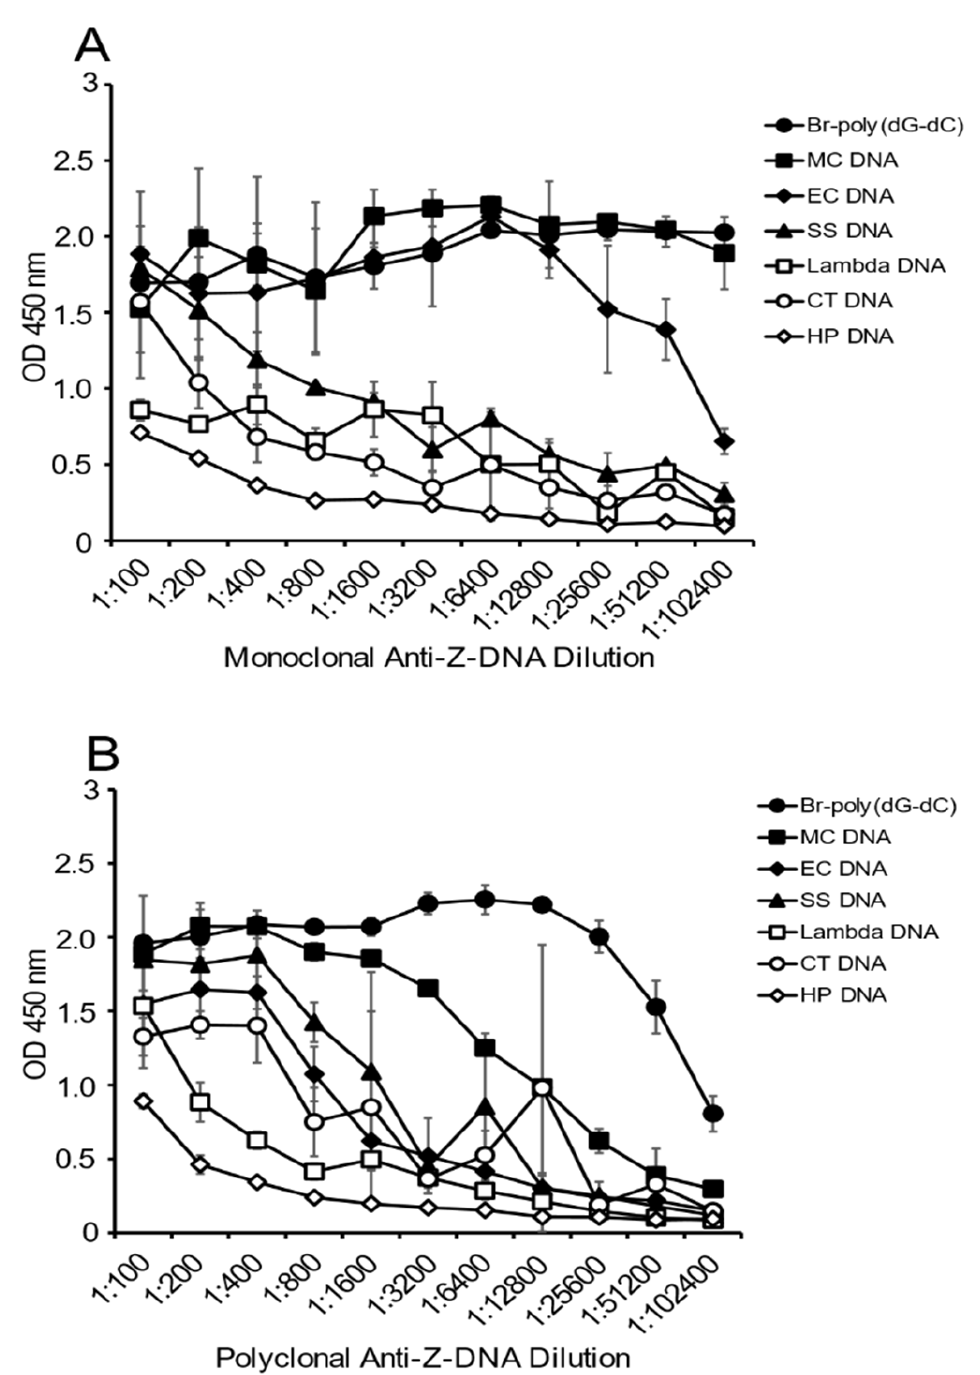
Figure 2. The effect of antibody dilution on the binding of monoclonal and polyclonal anti-Z-DNA antibodies to natural DNA. The binding of various dilutions of monoclonal and polyclonal anti-Z- DNA antibodies to DNA coated at a concentration of 2.5 µ g/mL was assessed by ELISA. ( A ) Results for the monoclonal antibody; ( B ) results for the polyclonal antibody. Results are reported in terms of OD 450 nm values. All treatments were performed in duplicate. The means and standard deviations are presented.